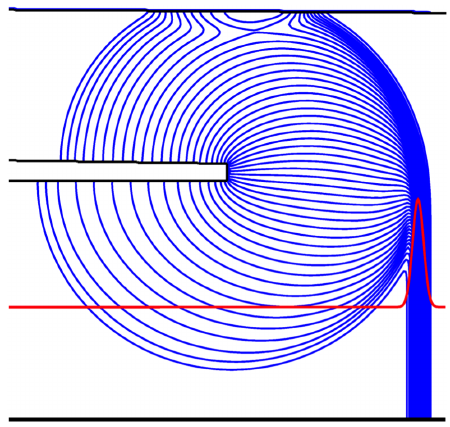
FIG. 1. Electric force field line distribution at the time when a relatively short bunch has just passed a pipe connection. The red line shows the bunch line charge density distribution and the bunch trajectory.